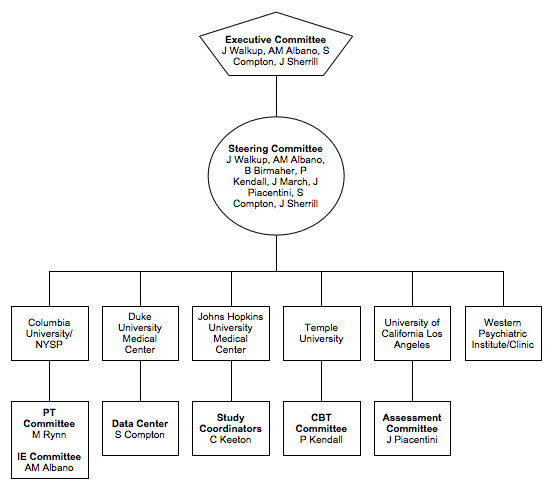
Child/Adolescent Multimodal Study (CAMS) Organizational Structure and Performance Sites.